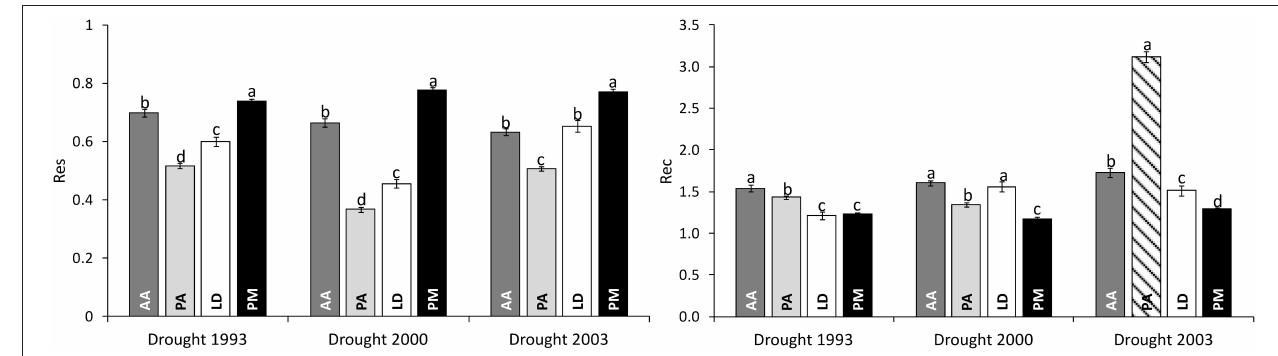
FIGURE 3 | Comparison of drought response of four conifers across three severe drought periods as given by Resistance (Res) and Recovery (Rec). Bar plots represent the mean values of all individuals of a certain species; whiskers give the standard error. The striped bar marks a biased estimate of recovery due to the short time interval of subsequent drought events. AA, Abies alba ; PA, Picea abies ; LD, Larix decidua ; PM, Pseudotsuga menziesii . Lower case letters a, b, c, and d mark significant differences determined in pairwise post-hoc tests.